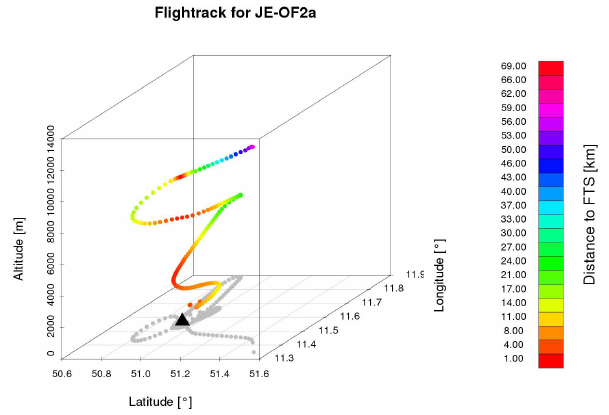
Fig. 2. A typical aircraft profile with spiral close to the FTS loca- tion. This figure shows the overflight JE-OF2a. The black triangle symbols the location of the FTS. The colors of the dots symbolize the distance of the aircraft to the FTS, the grey dots are a projection of the flight path on the ground. The corresponding aircraft data are shown in Fig.